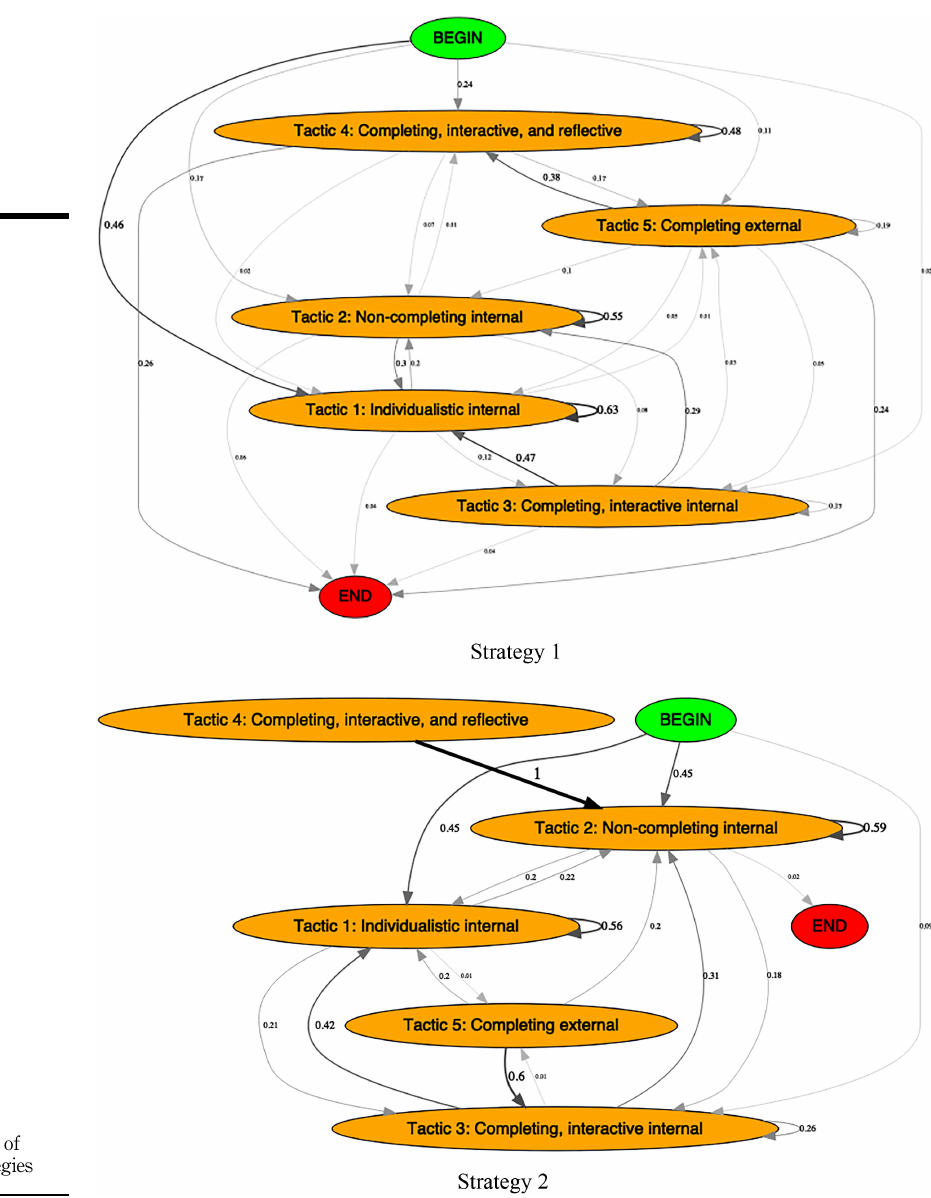
Figure 3. Process model of learning